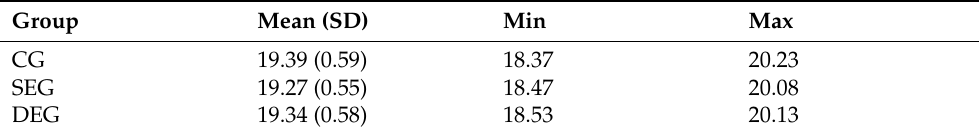
Table 4. Mean beak length, standard deviation, and minimum and maximum values in mm measured at nine visits in weeks of life 19, 24, 28, 31, 35, 41, 54, 62, 70, and 77, in three groups (CG = control group, SEG= single enrichment group, DEG = double enrichment group).